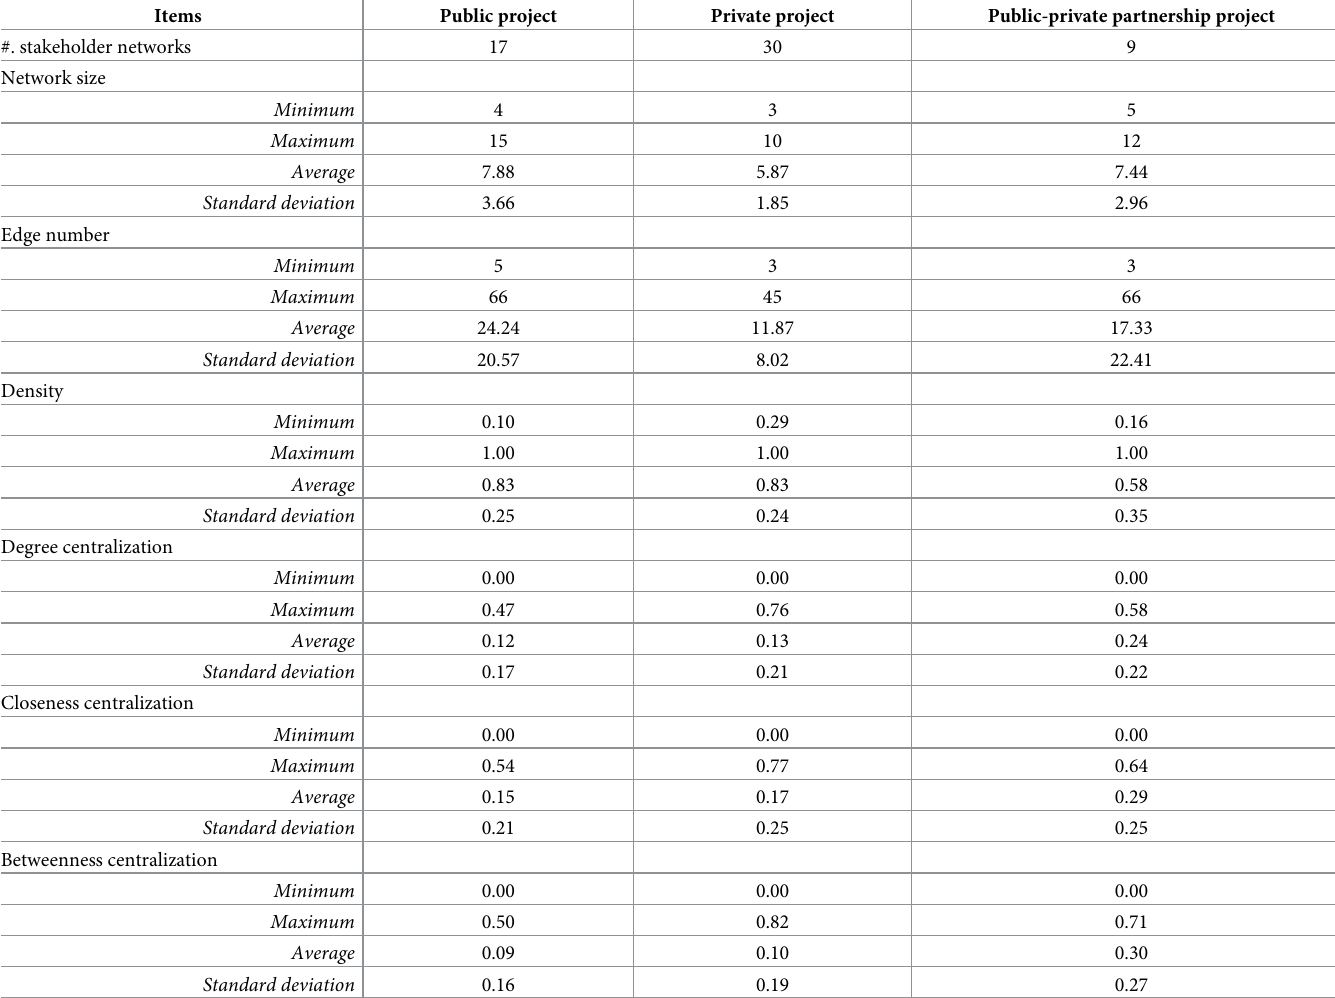
Table 1. Basic network statistics of the 56 stakeholder networks resulting from the survey response data used for this study. Items